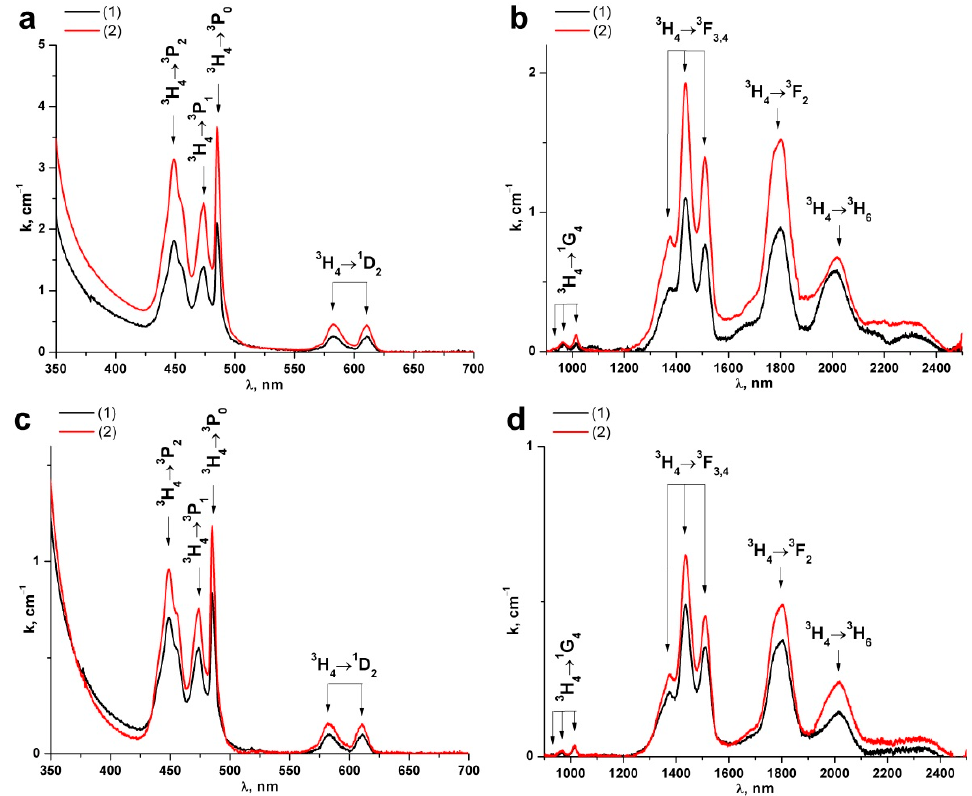
Figure 3. Absorption spectra of Pr 3+ /Pr 4+ ions in the crystals: ( a , b ) (ZrO 2 ) 0.805 (Y 2 O 3 ) 0.188 (Pr 2 O 3 ) 0.007 ; ( c , d ) (ZrO 2 ) 0.802 (Y 2 O 3 ) 0.195 (Pr 2 O 3 ) 0.003 ; (1) beginning of growth and (2) end of growth.